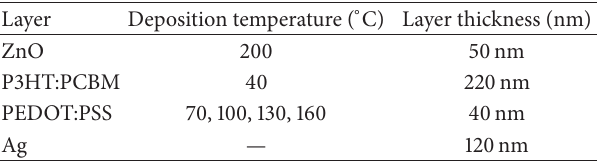
Table 1: The deposition temperature and thickness of each func- tional layer in